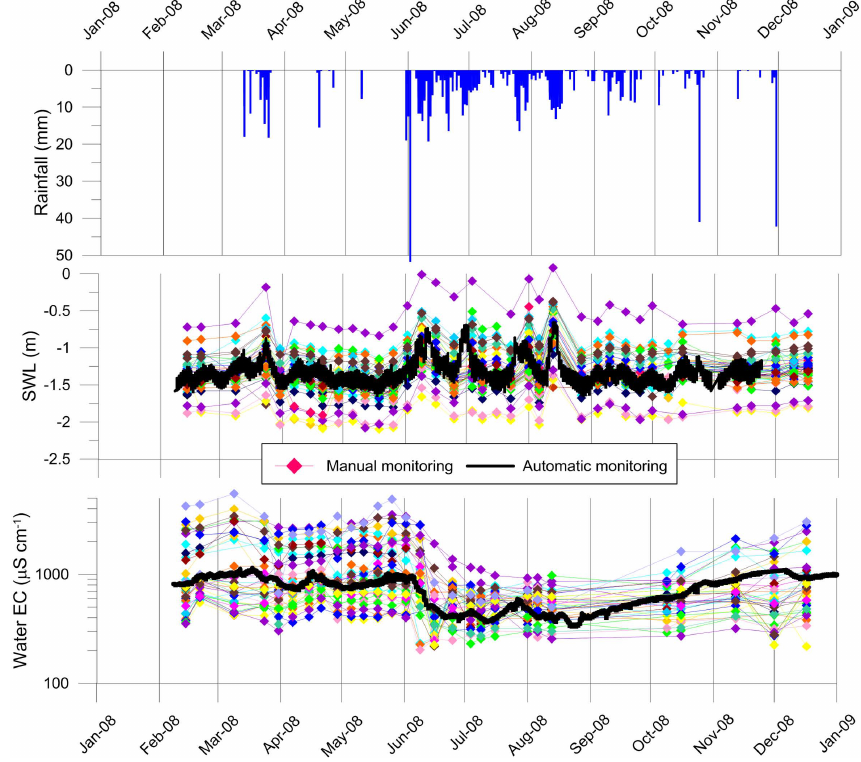
Fig. 8. Rainfall, water level and water EC monitoring. SWL is the static water level measured in